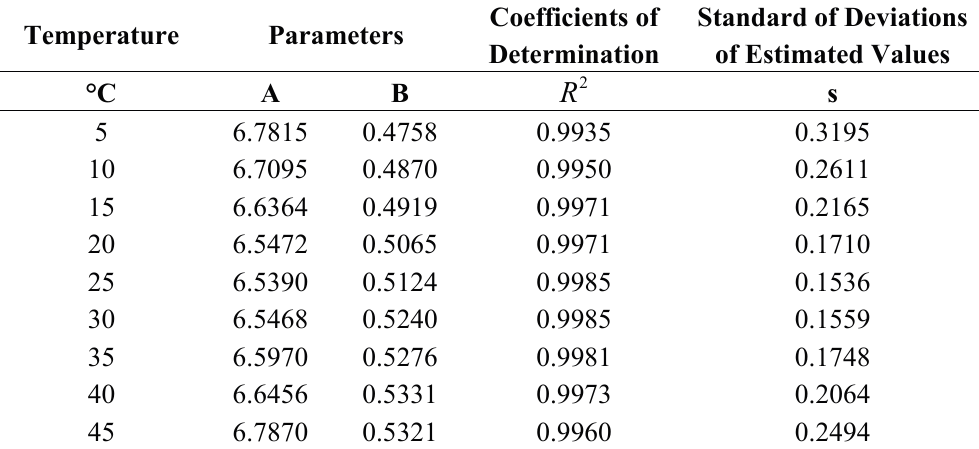
Table 3. Estimated values of parameters in the Oswin